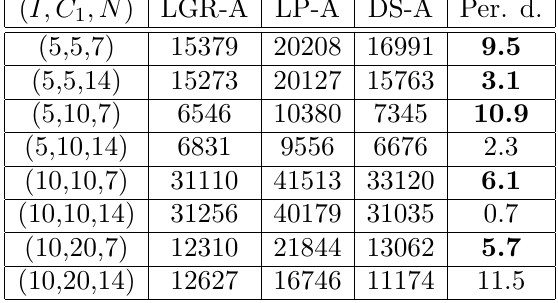
Table 2. Results for λ = 0 . 99.